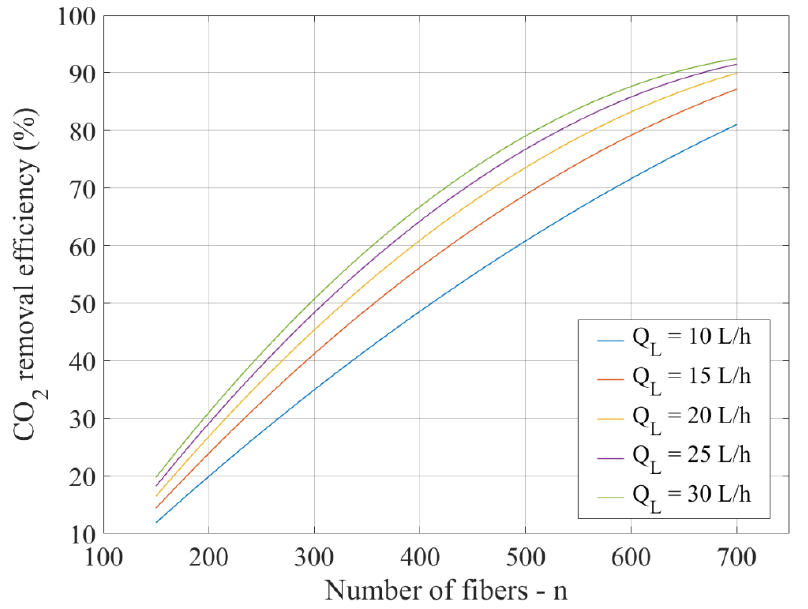
Figure 10. Effect of the number of fibers on the CO 2 removal efficiency at different liquid flow rates, Q G = 2L · min − 1 .